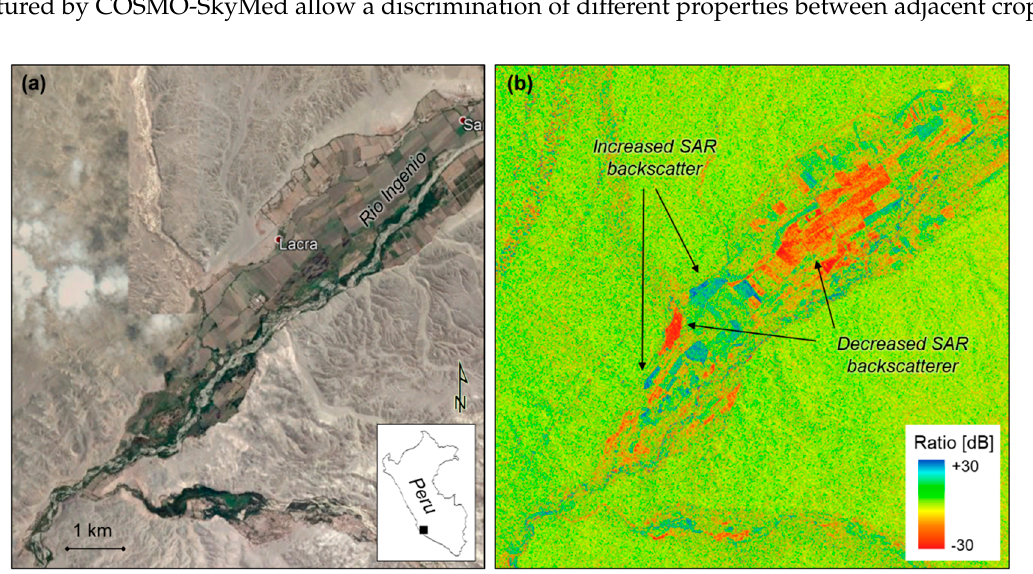
Figure 7. ( a ) Satellite view of the valley of Rio Ingenio, near the town of Lacra in Peru (Google Earth image © 2018 DigitalGlobe); and ( b ) change detection map based on the ratio of the SAR backscattering coefficient between a pair of COSMO-SkyMed StripMap Himage mode (~3 m ground resolution) scenes acquired on 03 / 06 / 2018 and 18 / 07 / 2017. Areas in yellow to red indicate a decrease in the SAR backscatter occurred between 2017 and 2018, while areas in light to dark blue indicate an increase in the SAR backscatter (e.g., increased soil moisture content). COSMO-SkyMed ® Products © ASI—Italian Space Agency—2017–2018. All Rights Reserved.